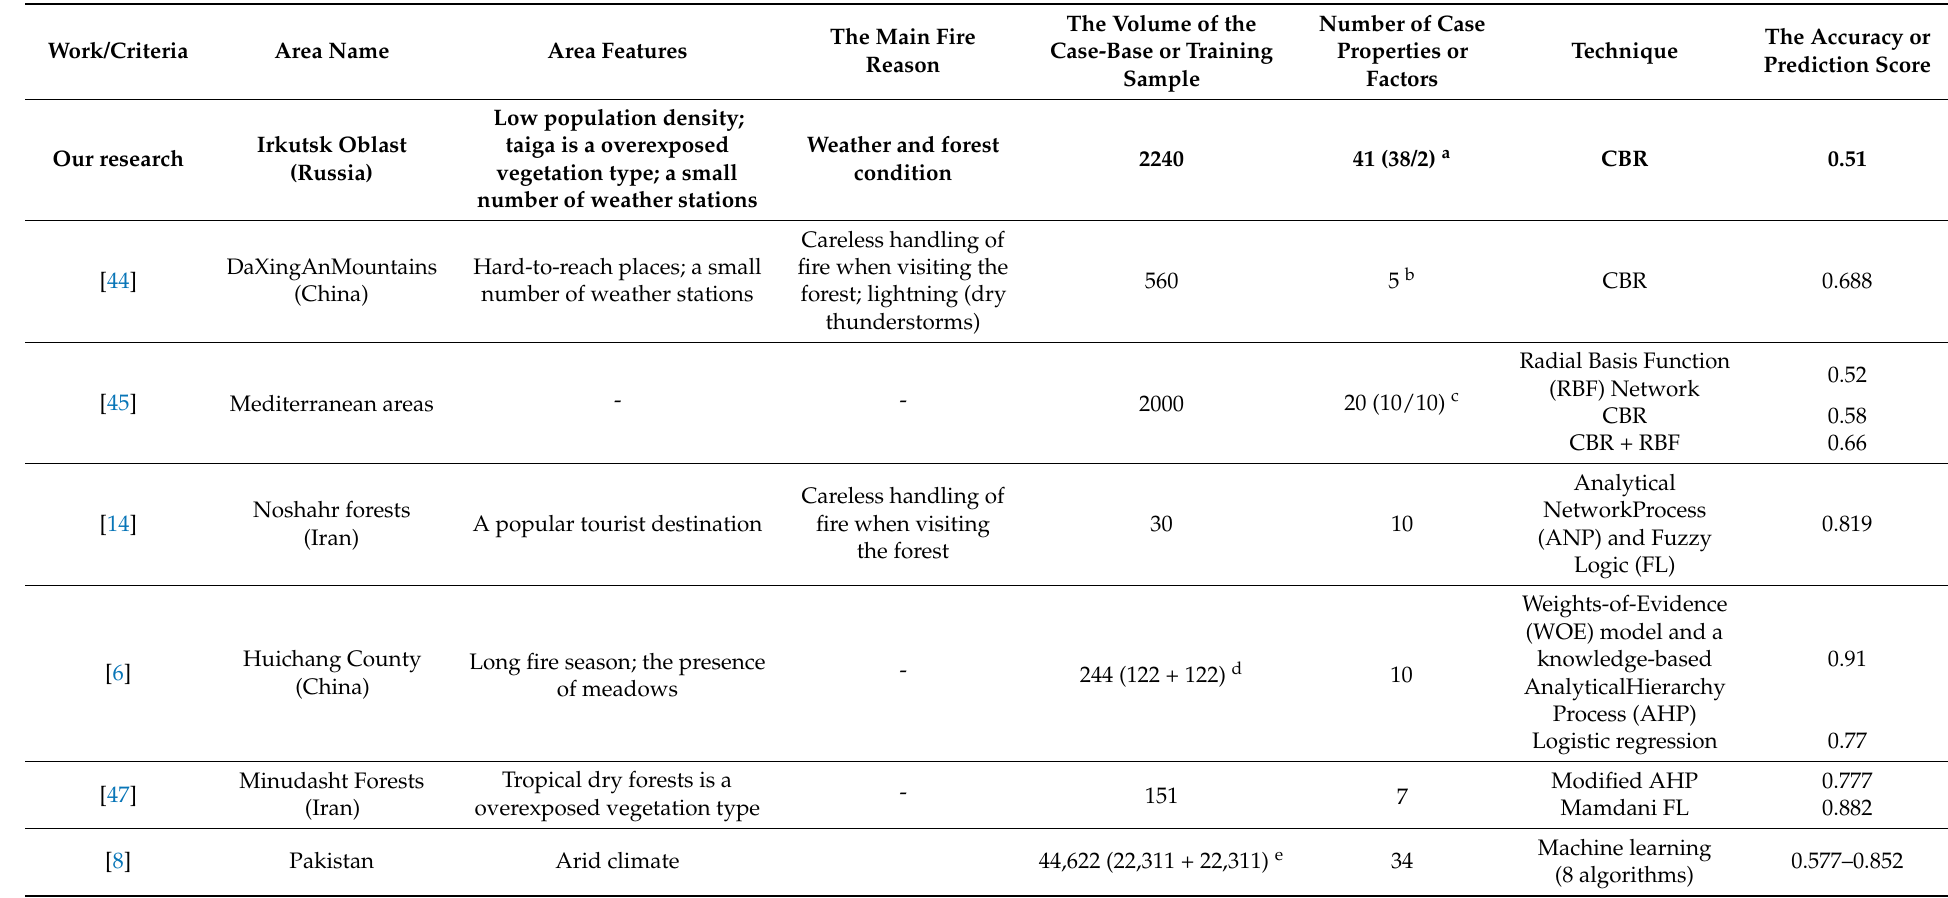
Table 4. A comparison with existing